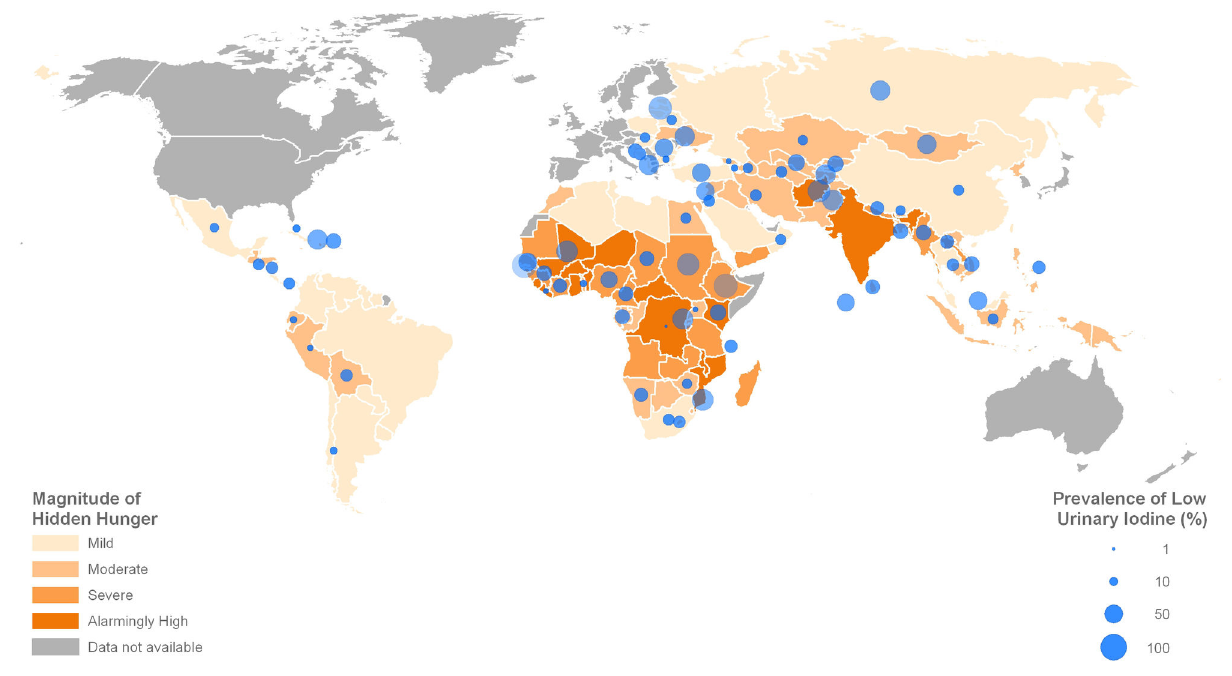
Figure 2. Global map presenting hidden hunger index based on the prevalence estimates (HHI-PD) in 149 countries and prevalence of low urinary iodine concentration in 90 countries with 2007 Human Development Index <0.9. The hidden hunger index HHI-PD was estimated based on national estimates of the prevalence of stunting, anemia due to iron deficiency, and low serum retinol concentration. doi: